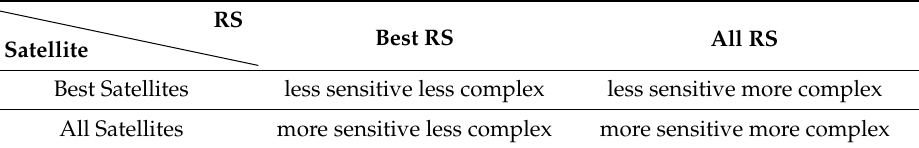
Table 3. Parameters of CD process.